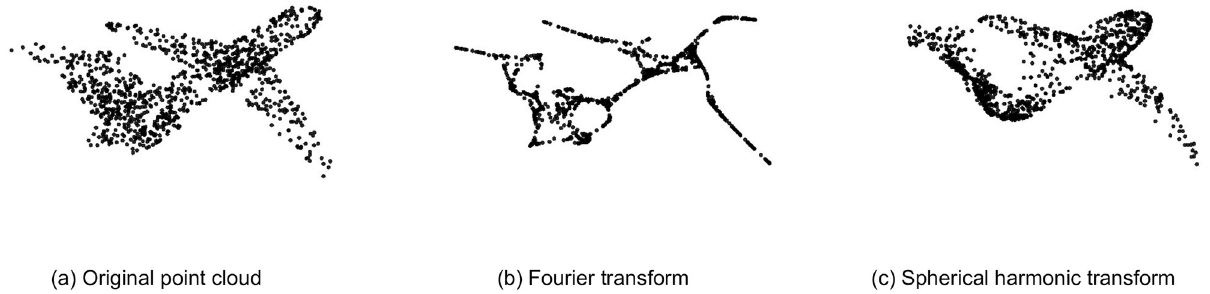
Fig 3. Comparison of low-frequency point cloud information of a random ModelNet40 sample. Spherical harmonic transformation removes corners and preserves point clouds’ uniform distribution. In contrast, Fourier transformation extracts a skeleton of point clouds very narrowly.